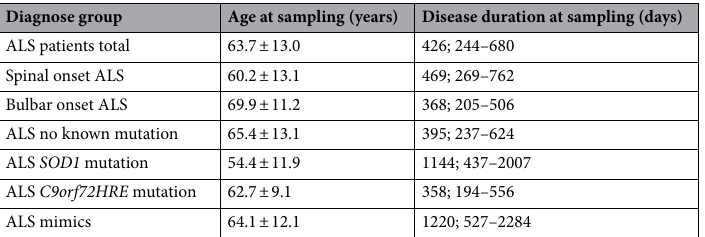
(Table 2). For a prognosis-relevant presentation of biomarkers, ALS patients were also categorized according to the years of survival from symptom onset. The survival times were < 2 years, 2 to < 5 years, 5 to < 10 years and ≥ 10; the biomarker estimates for ALS survival groups are presented as arithmetic mean, standard devia- tion (SD) and 95% confidence interval (CI) (Table 2). Distributions of biomarker estimates for ALS patients with ≥ 10 years survival are not reported in Table 2 due to the low sample size in this group. Prior to analyses, biomarker estimates were log 10 -transformed to reduce the influence of inhomogeneous variance, reduce distri- butional skewness, improve normal approximation and decrease the influence of outliers. To compare differ- ent relevant groups, one-way analysis of variance (ANOVA) was performed with planned comparison contrast tests and a 95% CI bias-corrected and accelerated bootstrap initially set at 1000 sample runs. In the statistical comparison of CSF NFL concentrations, sample runs had to be increased to 3000 to achieve convergence (stable p -values above or below < 0.05). For other statistical tests, there was no need to increase the number of samples per run beyond 1000 to achieve convergence. The Welch test was used when homogeneity of variance could not be assumed. Contrast tests were designed to I) test significant differences between ALS patients and all other groups individually; II) test significant differences between patients with other MNDs compared to those with